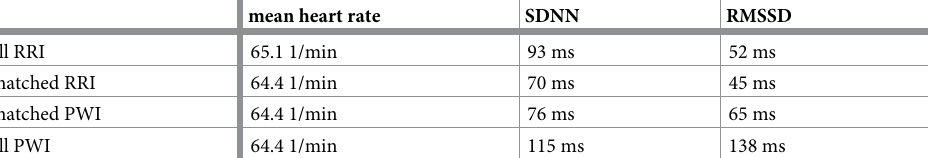
Table 4. Comparison of heart rate and HRV parameters from RRI and PWI. We calculated mean heart rate, SDNN, and RMSSD for (i) all RRI detected in the ECGs, (ii) all RRI associated with PWI (at an accuracy limit of 0.1 s, see Table 2), (iii) all PWI associated with RRI, and (iv) the total set of all detected PWI. Group averages over 351 subjects with detected PWIs are